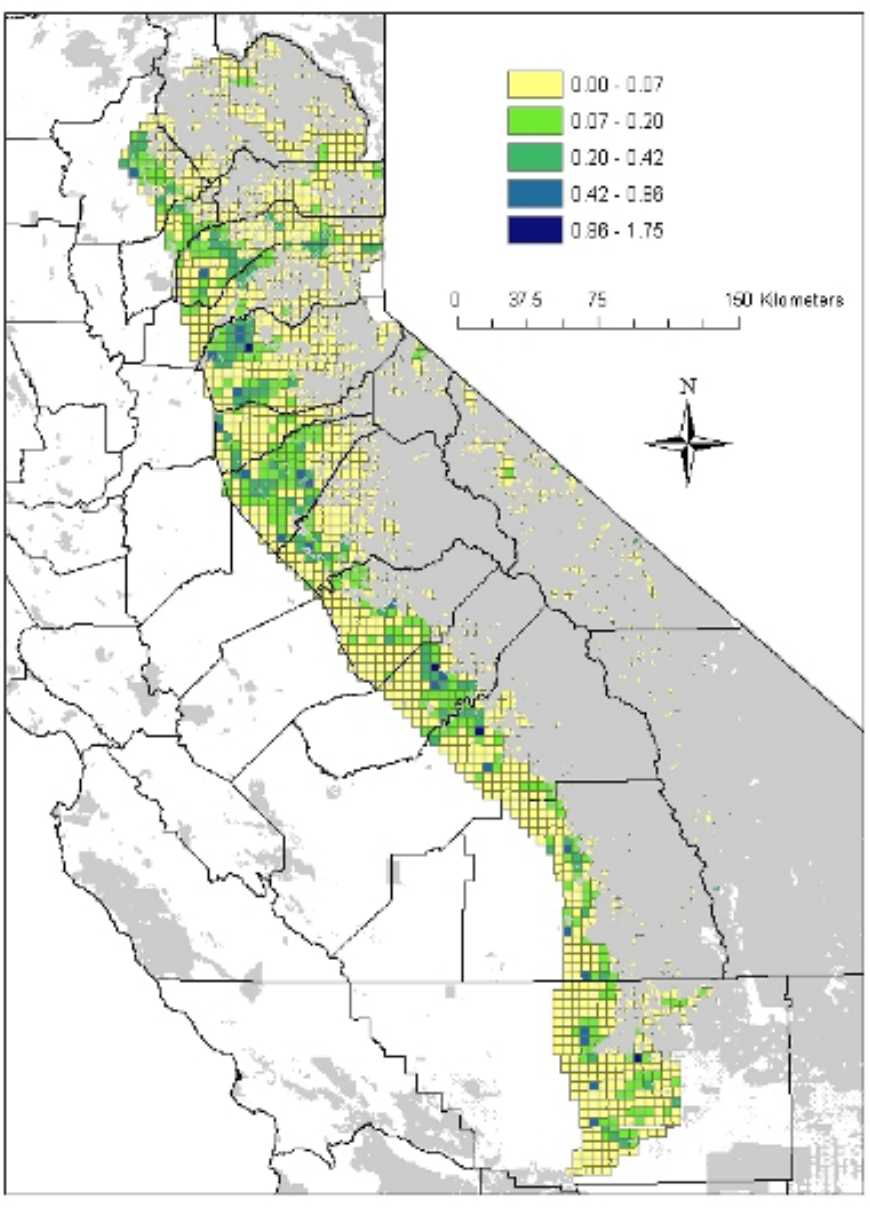
Fig. 10. Composite site scores derived by summing the scores for three conservation criteria (Figures 6, 8, and 9). Criteria were weighted equally in this